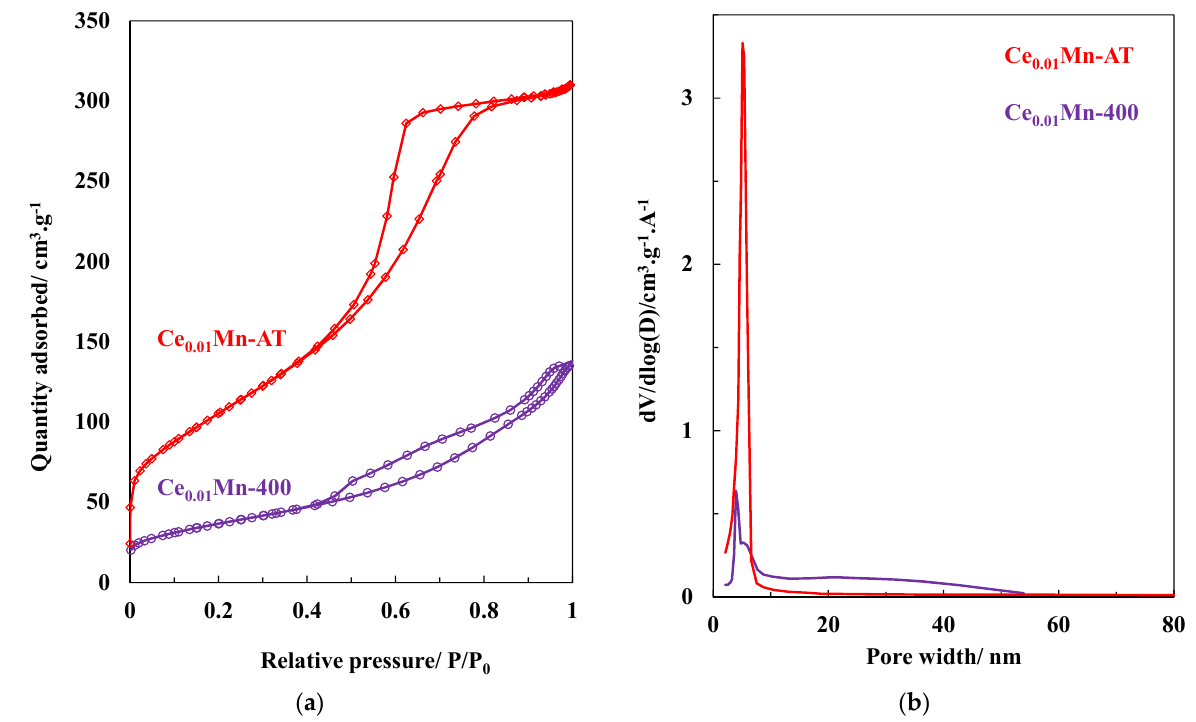
Figure 2. ( a ) N 2 adsorption and desorption and ( b ) pore size distribution of Ce 0.01 Mn-400 and Ce 0.01 Mn-AT samples. Table 2. Textural properties of the Ce 0.01 Mn-400 and Ce 0.01 Mn-AT samples.